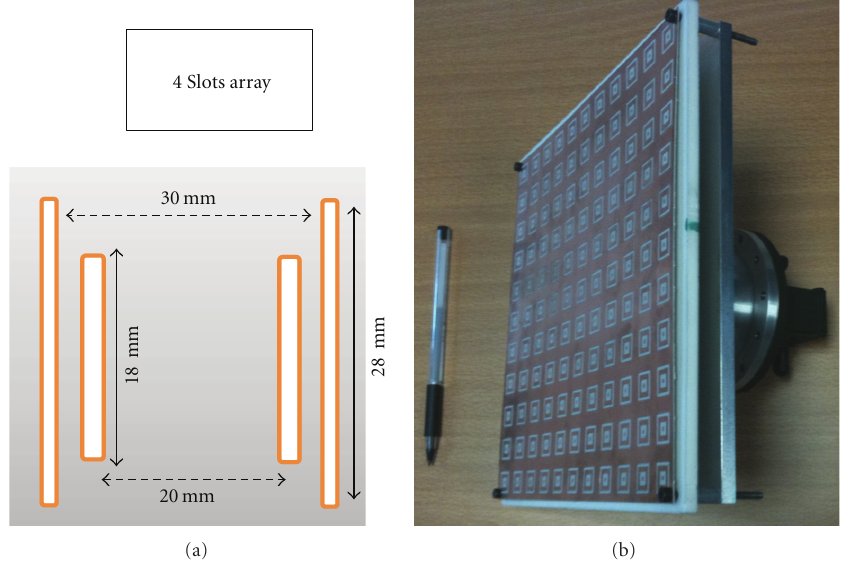
Figure 4: Photography of a 4 slots array λ/ 2 (a) and the manufactured EBG dual-band antenna (b).